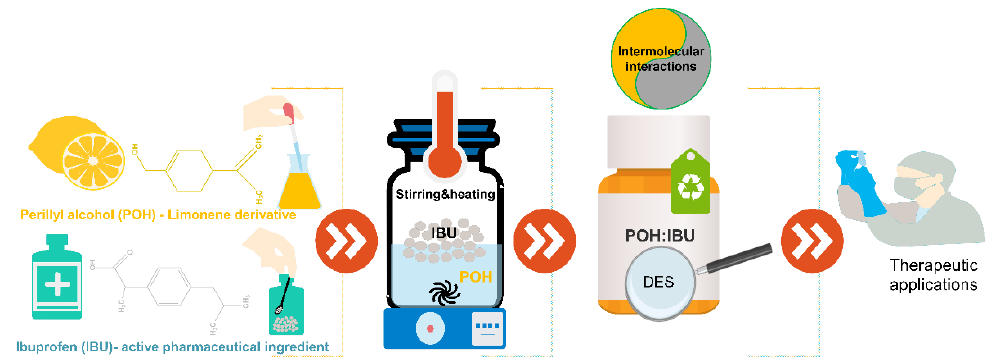
Figure 1. Schematic illustration of the developed perillyl alcohol (POH)-based THEDES.